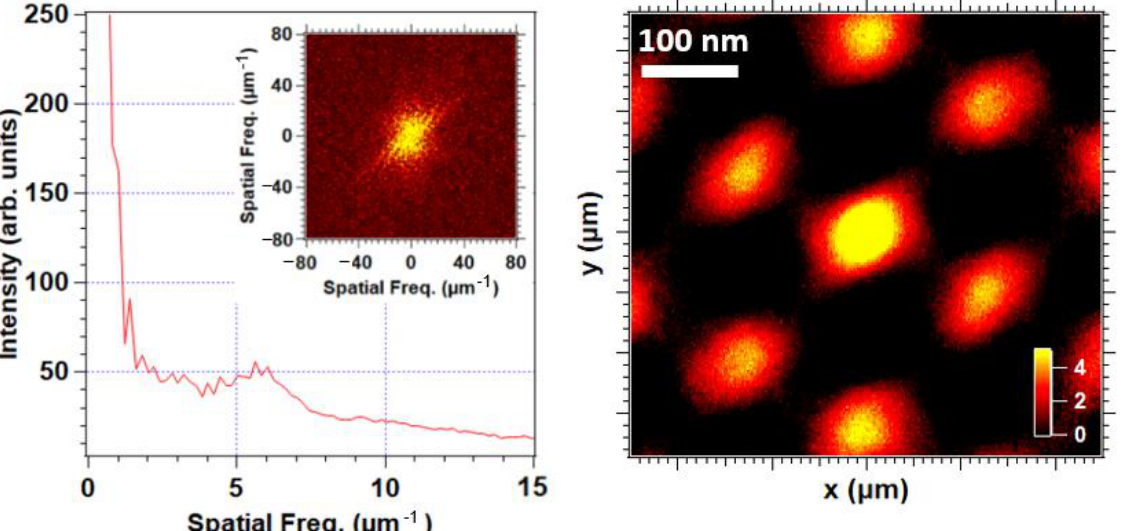
Figure A1. DLS data (left) showing the distribution of the nanoparticles following growth of the core, interlayer, and shell, with the Gaussian fits denoted by the dashed lines of the respective color. The y -axis denotes the percentage of the total number of particles of each size contributing to the total scattering intensity. A reproducibly low polydispersity index (PDI) of approximately 0.006 was obtained for the final CIS particles, of a diameter of 151 nm. This was calculated by Malvern Zetasizer proprietary software as 𝑃𝐷𝐼 = (𝑠𝑡𝑎𝑛𝑑𝑎𝑟𝑑 𝑑𝑒𝑣𝑖𝑎𝑡𝑖𝑜𝑛 𝑚𝑒𝑎𝑛⁄ ) 2 [37]. TEM of a 40 BIOS opal after microtoming showing random hexagonal close packing (right).